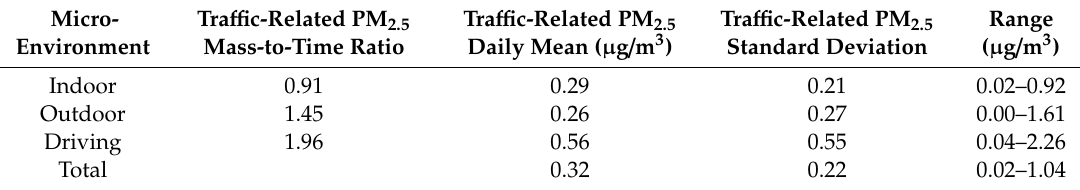
Table 2. Traffic-related PM 2.5 concentration (µg/m 3 ) in three microenvironments over the 50 measurement days.